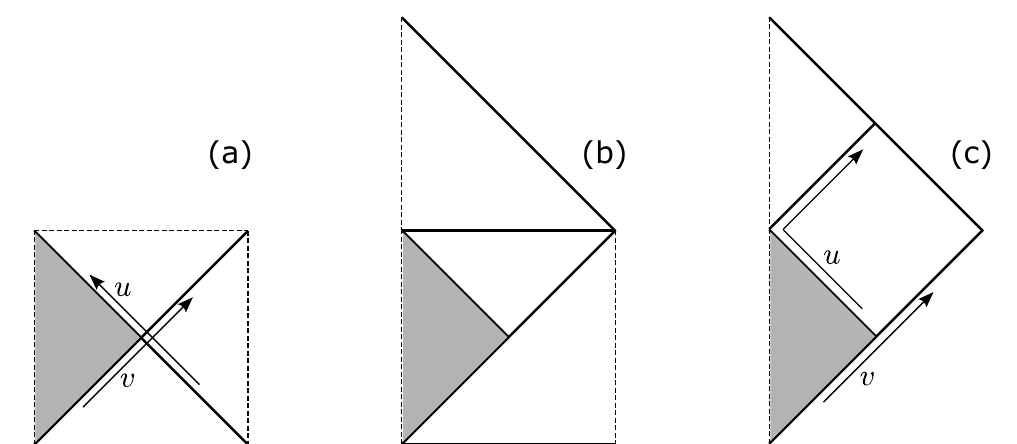
Figure 1 . Penrose diagrams of the dS 4 static-patch problem and its Minkowski counterpart. (a) The static patch (in gray) inside dS 4 ; its past and future lightlike boundaries have been “doubled” into geodesically complete cosmological horizons. (b) The dS 4 Poincare patch associated with the past horizon, and its extension into a full Minkowski space through the future boundary of dS 4 . The static patch, still in gray, is a subregion of both dS 4 and Minkowski. (c) The Minkowski picture, with dS 4 removed. The static patch is now the causal past of the origin, the past horizon is past lightlike infinity, and the future horizon is the origin’s lightcone. This lightcone is again a geodesically complete “doubling” of the static patch’s future boundary, but now the completion is into the